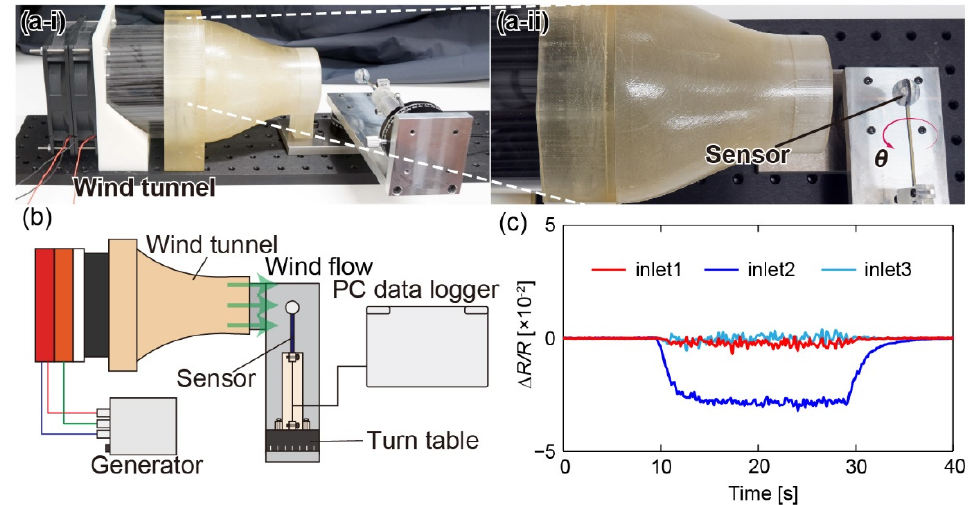
Figure 7. ( a ) Photograph of ( i ) overall and ( ii ) close-up, and ( b ) concept of the experimental setup to measure the sensor response against airflow. ( c ) Responses of the DP sensors against airflow when the wind velocity and direction are 10 m/s and 0°, respectively.